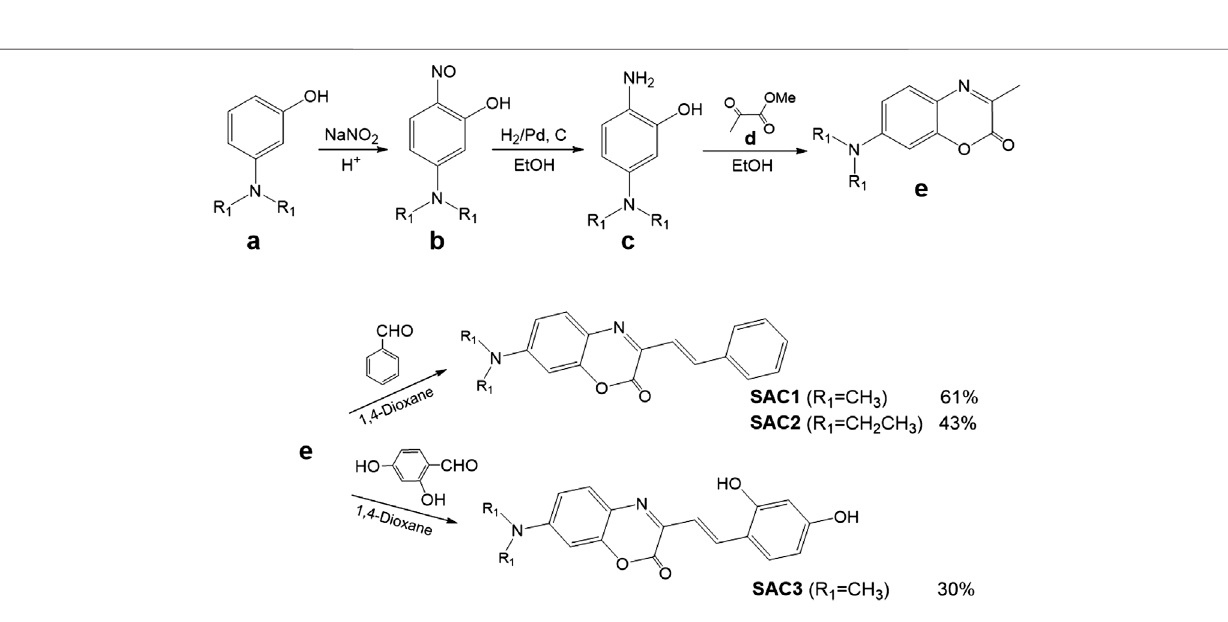
SCHEME 1 | Synthetic routes to obtain the SAC series ( SAC1-3